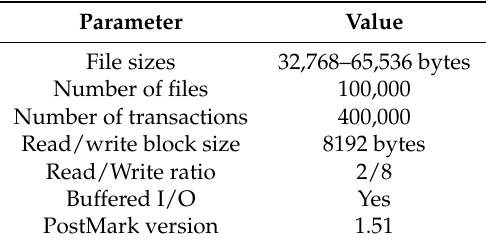
Table 3. PostMark Configuration Details.